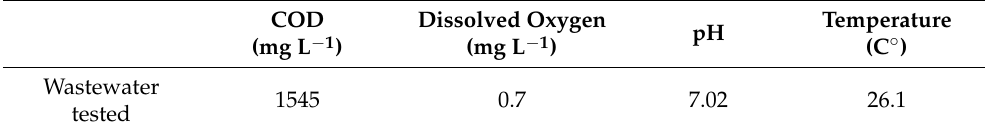
Table 1. Initial physico-chemical parameters of wastewater.